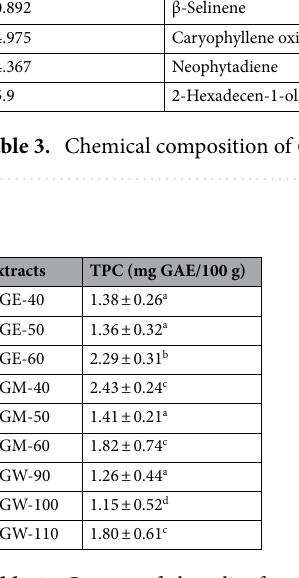
Table 4. Content of phenolics from different O. gratissimum extracts. Values shown are mean of three replicates (n = 3) ± SD. Values with different superscript lowercase letter (a–d) within each column are significantly different ( P ≤